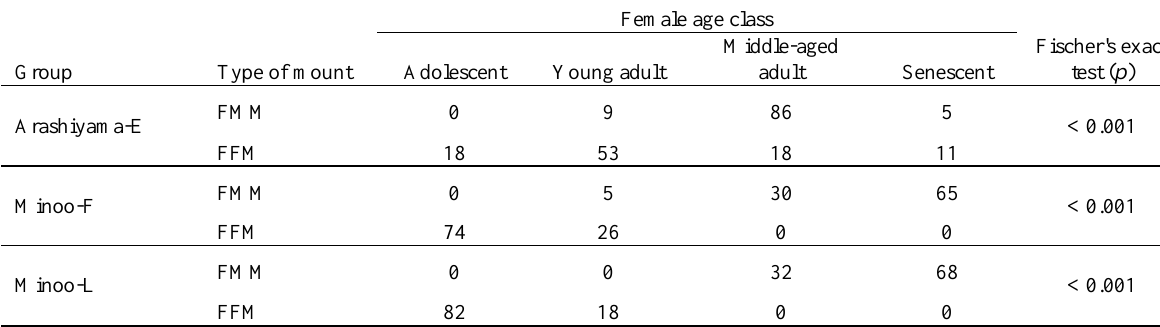
Female age class Fischer's exact Middle-aged test ( p ) Group Type of mount Adolescent Young adult adult Senescent < 0.001 < 0.001 < 0.001